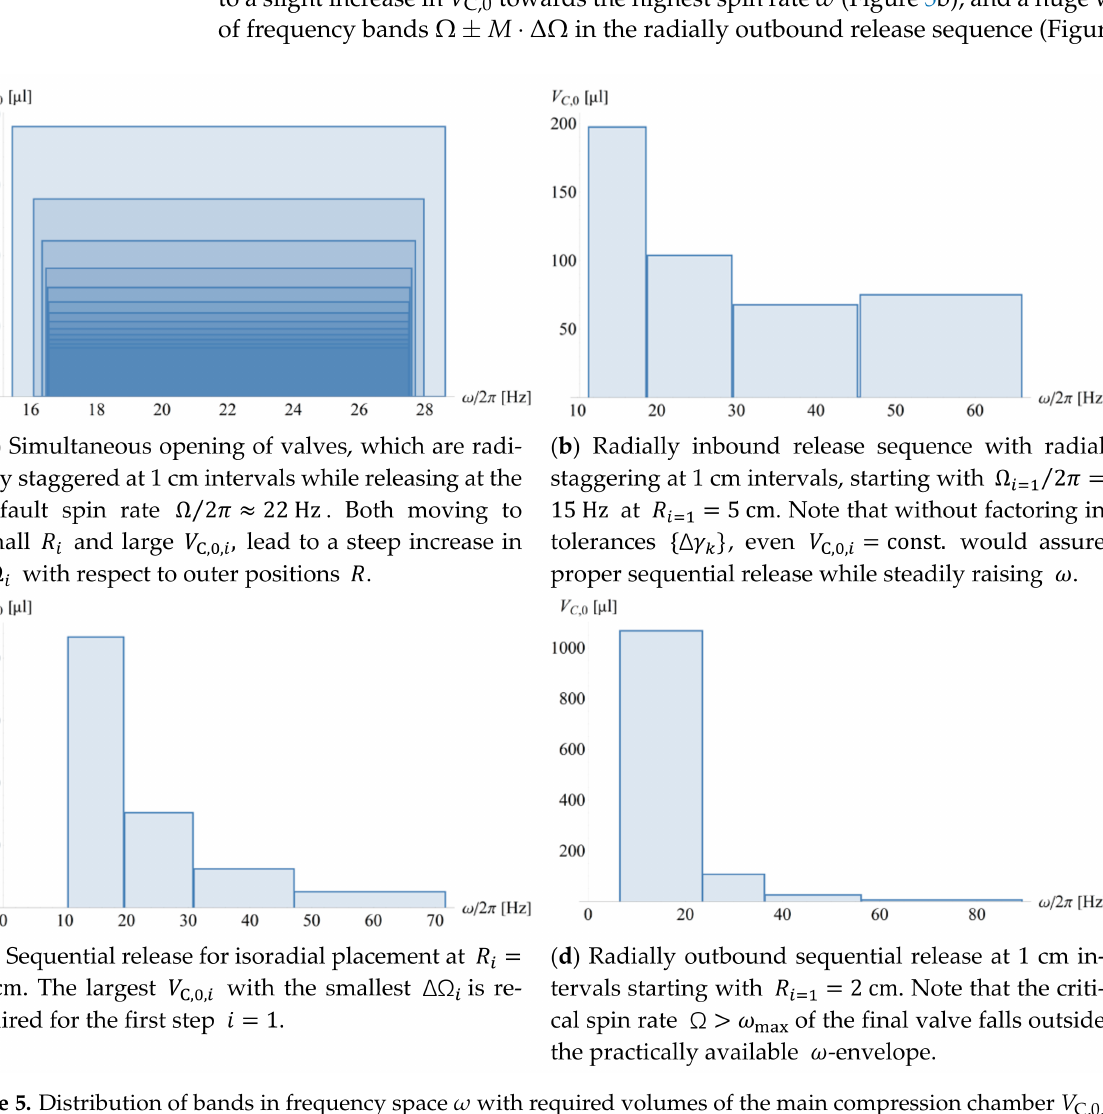
− M · ∆Ω > Ω + M · ∆Ω i i i − 1 i − 1